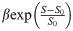
Schematic diagram of compartment model for C. difficile dynamics in a 350 beds internal medicine department.Patients in the susceptible state (S) are admitted to the department at a specific rate (γ). They can be discharged from the department in the same susceptible state (discharge rate—β) or they can acquire C. difficile during hospitalization. Acquisition can be from either infected patients (at a particular transmission rate per day: α1) or from asymptomatic carriers (at a different transmission rate per day: α2). The transmission rate α1 can be decreased by better isolation of infected patients and better detection of infected patients by the use of a more sensitive test. The transmission rate α2 is not influenced from better isolation or detection. Among susceptible patients who acquire C. difficile during hospitalization, the risk of becoming clinically infected is δ, and the risk of becoming an asymptomatic carrier is (1-δ). The discharge rate for susceptible patients (β) can change according to ward occupancy; if the number of susceptible patients exceeds a predetermined level (S0) then susceptible patients will be discharged in a faster rate (βexp(S−S0S0) in order to prevent overcrowding. Patients in asymptomatic carrier (C) or infected (I) compartments can transfer from the S compartment (see above) or arrive at the department already in the carrier or infected state (ε). Within this group of imported cases, the risk of being infected is δ, and the risk of being a carrier is (1-δ). Discharge rate (θ) is equal for infected patients and carriers.